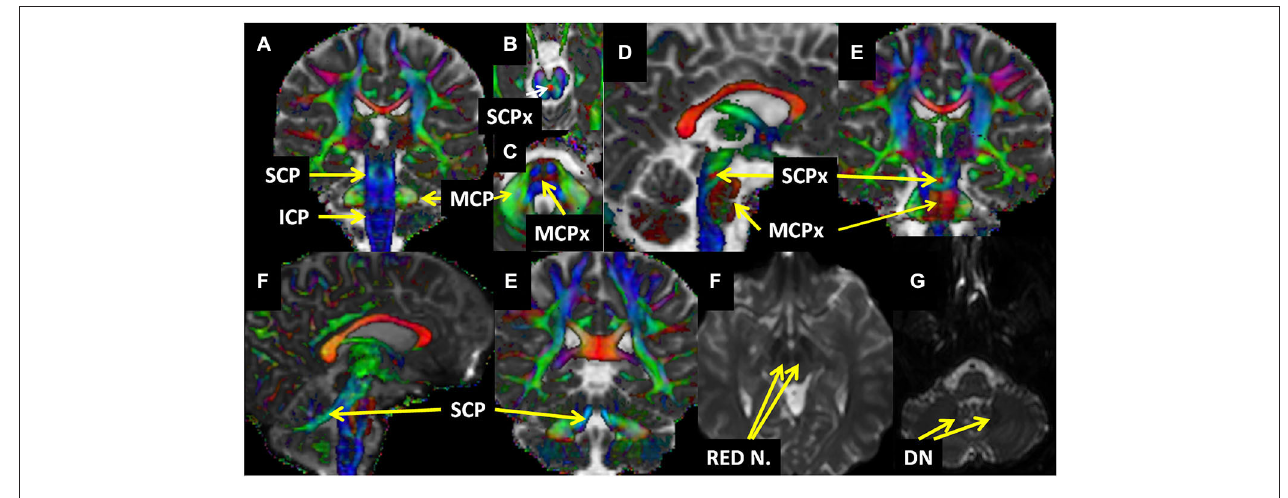
Nucleus, ICP: Inferior Cerebellar Peduncle, MCP: Middle Cerebellar Peduncle, MCPx: Middle Cerebellar Peduncle Crossing, Red N.: Red Nuclei, SCP: Superior Cerebellar Pedunles, SCPx: Superior Cerebellar Pedunles